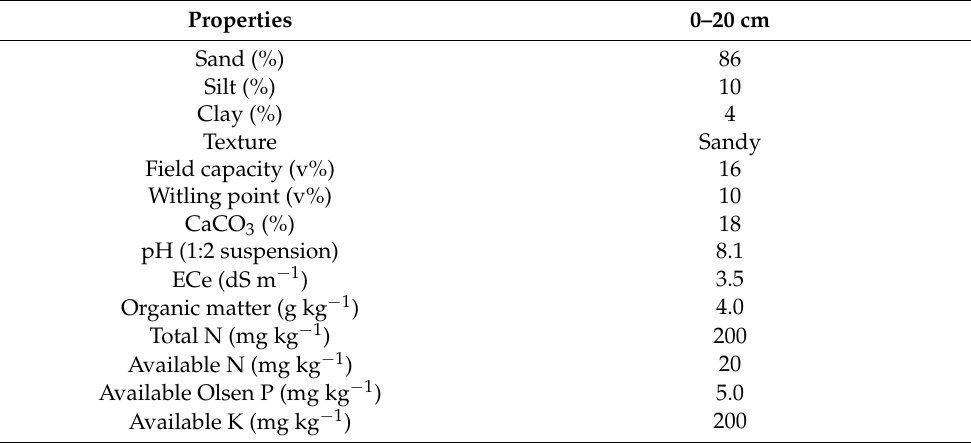
Table 1. Some physical and chemical soil properties (0–20 cm) of the studied soil. Properties 0–20 cm Sand (%) 86 Silt (%) 10 Clay (%) 4 Texture Sandy Field capacity (v%) 16 Witling point (v%) 10 CaCO 3 (%)